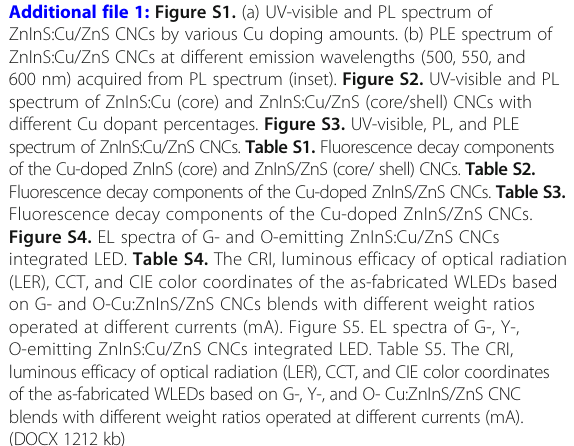
Additional file 1: Figure S1. (a) UV-visible and PL spectrum of ZnInS:Cu/ZnS CNCs by various Cu doping amounts. (b) PLE spectrum of ZnInS:Cu/ZnS CNCs at different emission wavelengths (500, 550, and 600 nm) acquired from PL spectrum (inset). Figure S2. UV-visible and PL spectrum of ZnInS:Cu (core) and ZnInS:Cu/ZnS (core/shell) CNCs with different Cu dopant percentages. Figure S3. UV-visible, PL, and PLE spectrum of ZnInS:Cu/ZnS CNCs. Table S1. Fluorescence decay components of the Cu-doped ZnInS (core) and ZnInS/ZnS (core/ shell) CNCs. Table S2. Fluorescence decay components of the Cu-doped ZnInS/ZnS CNCs. Table S3. Fluorescence decay components of the Cu-doped ZnInS/ZnS CNCs. Figure S4. EL spectra of G- and O-emitting ZnInS:Cu/ZnS CNCs integrated LED. Table S4. The CRI, luminous efficacy of optical radiation (LER), CCT, and CIE color coordinates of the as-fabricated WLEDs based on G- and O-Cu:ZnInS/ZnS CNCs blends with different weight ratios operated at different currents (mA). Figure S5. EL spectra of G-, Y-, O-emitting ZnInS:Cu/ZnS CNCs integrated LED. Table S5. The CRI, luminous efficacy of optical radiation (LER), CCT, and CIE color coordinates of the as-fabricated WLEDs based on G-, Y-, and O- Cu:ZnInS/ZnS CNC blends with different weight ratios operated at different currents (mA). (DOCX 1212 kb) Abbreviations CB: Conduction band; CCT: Color coordinate temperature; CIE: Commission Internationale de l ’ Enclairage; CNCs: Colloidal nanocrystals; CQDs: